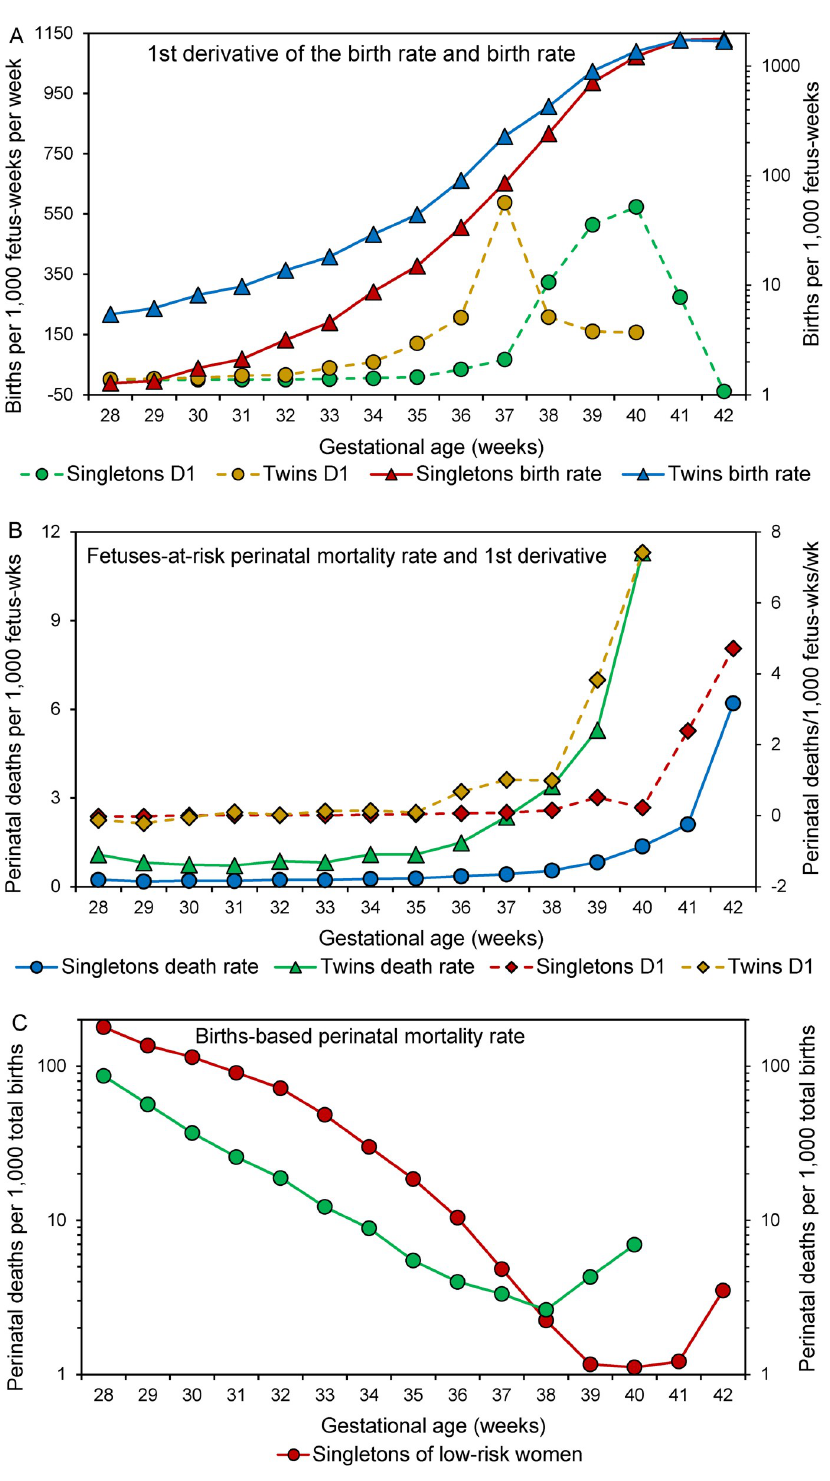
Fig 3. Gestational age-specific birth rates and their first derivatives among singletons of low-risk women (without hypertension or diabetes) and twins (Panel A), gestational age-specific fetuses-at-risk perinatal death rates and their first derivatives among singletons of low-risk women and twins (Panel B), and births-based gestational age-specific perinatal death rates (Panel C) among singletons of low-risk women and twins, United States, 2004–2015 (D1 denotes first